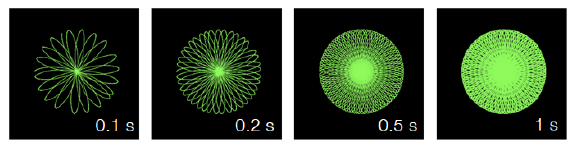
Figure 2. Livox MID-40 Sensor Non-Repeating Rosette Scan Pattern (Source: www.livoxtech.com)